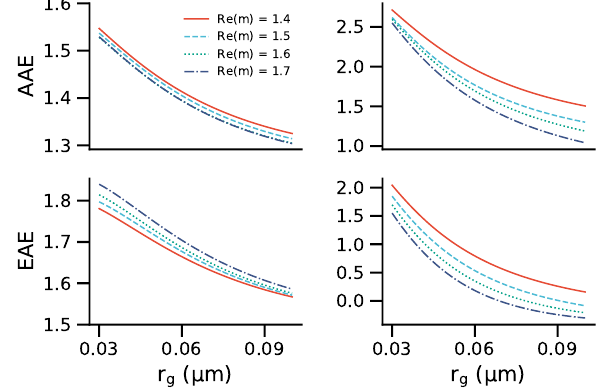
Figure 11. Similar to Figure 10, but for the sensitivity of the real part of BrC coatings RI